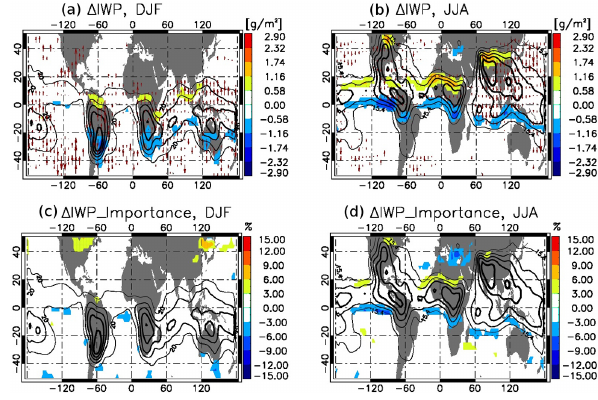
Figure 3. (cid:49) IWP (color shades; unit is gm − 2 ) between the south view and the north view with view-angle of 77 ◦ for December– January–February (a) and June–July–August (b) averaged during 2007–2010 between 11 and 17km. Results are based on CloudSat IWC data set within ± 50 ◦ latitude range. The corresponding per- centage difference of IWP (i.e., (cid:49) IWP / IWP, color shades; unit is %) is shown in (c) for DJF and (d) for JJA. The mean IWP within this altitude range is contoured in black with the contour interval equal to the minimum value shown on the contour line. Modern-Era Retrospective analysis for Research and Applications (MERRA) cloudy-sky meridional wind climatology during the same period is shown in arrow in (a) and (b) with wind speed linearly proportional to the arrow length. The longest arrow corresponds to 16ms − 1 in (a) and 9.15ms − 1 in (b) . Data in the top panels are smoothed by a 2 × 2 smoothing window.